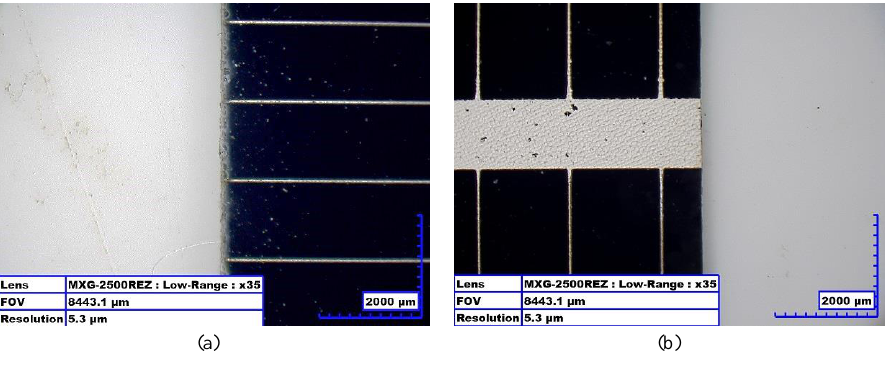
Fig. 4. Cutting: (a) without and (b) with laser.